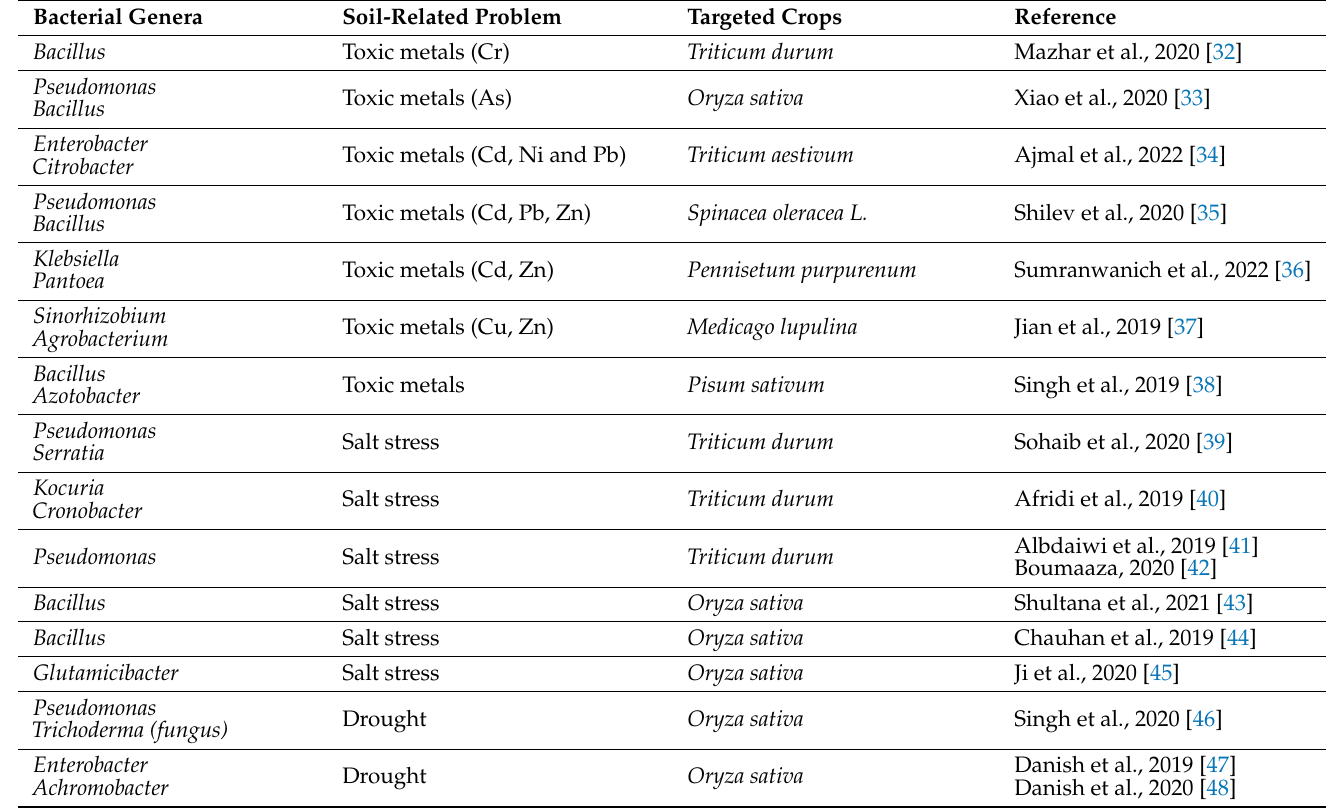
Table 1. Recent advances in soil remediation and plant growth restoration using beneficial soil